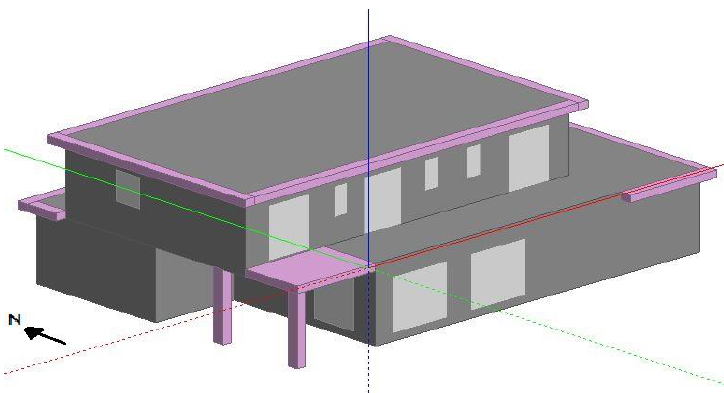
Figure 2. Three-dimensional model of the case study building. Energies 2020 , 13 , x FOR PEER REVIEW Table 5. Seasonal average energy efficiency for the analysed solutions.